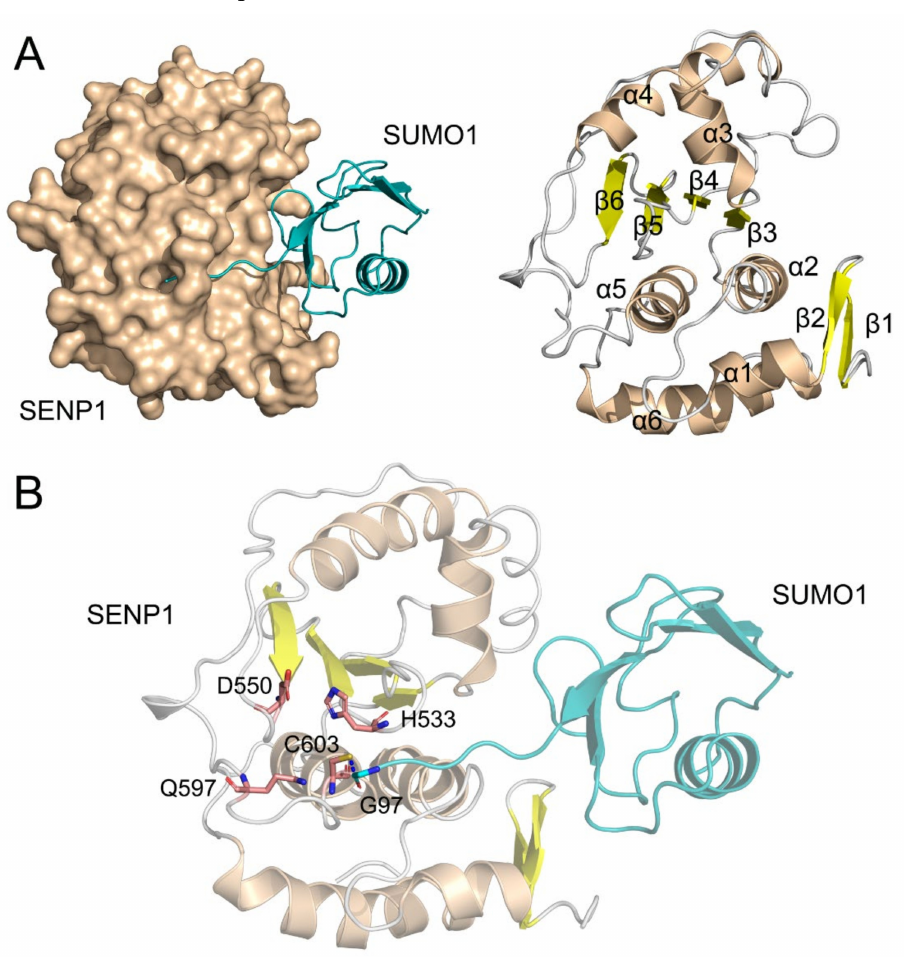
Figure 1. ( A ) Surface and cartoon representations of the C-terminal catalytic domain of SENP1 with SUMO1 (PDB ID: 2G4D). The secondary structural elements of α -helices, β -strands, and loops are colored using wheat, yellow, and gray, respectively; ( B ) Conformational rearrangement of the catalytic triad Cys603, His533, and Asp550 in the SENP1 active site. Cys603 of SENP1 forms a covalent thiohemiacetal linkage with the C-terminal carbonyl-C of Gly97 in SUMO1. Gln597 of SENP1 on the unstructured loop is shown as